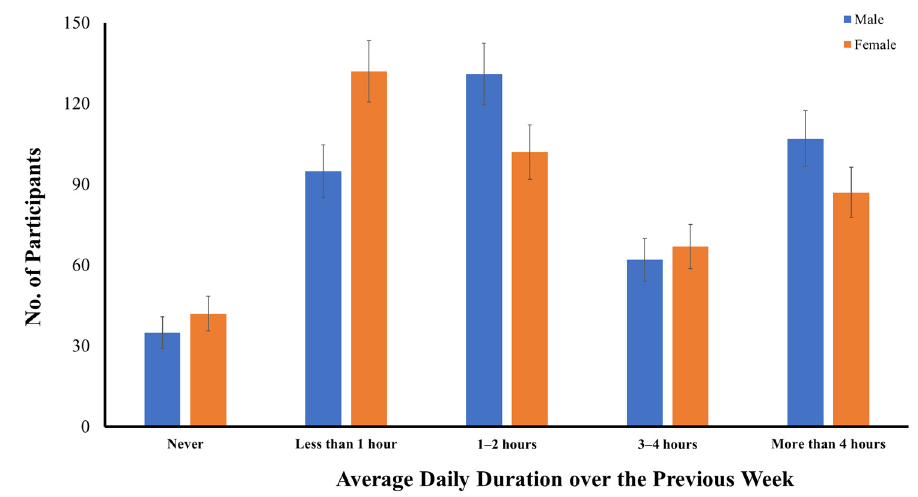
Figure 2. Distribution of early adolescents categorized across gender based on their average daily time spent using a computer over the previous week.